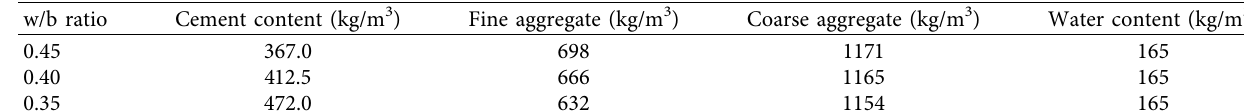
Table 3: Concrete mix proportion.